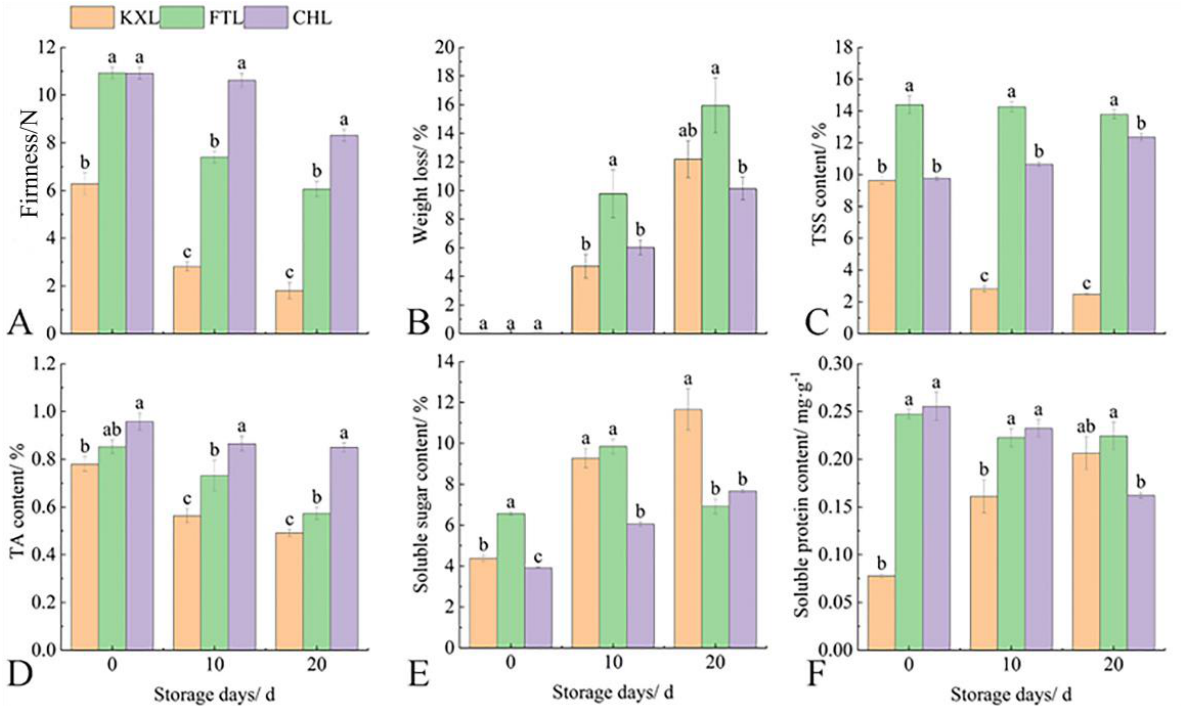
Figure 4. Changes in quality parameters among three plum cultivars during storage at room tem- perature. ( A ), Firmness; ( B ), weight loss; ( C ), TSS content; ( D ), TA content; ( E ), soluble sugar content; ( F ), soluble protein content. Note: vertical bars express the standard errors of the means ( n = 3). Different lowercase letters indicate significant differences for each storage period ( p < 0.05).